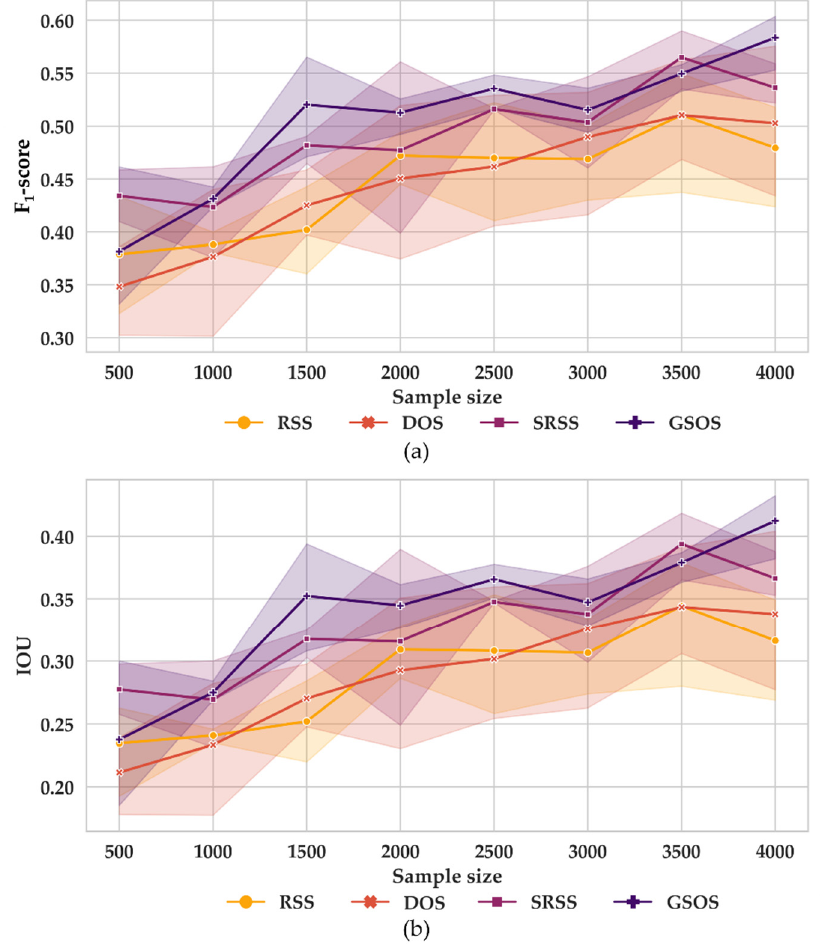
Figure 8. Learning curves. ( a ) Learning curve under the F 1 -score metrics; ( b ) learning curve under the IoU metrics.